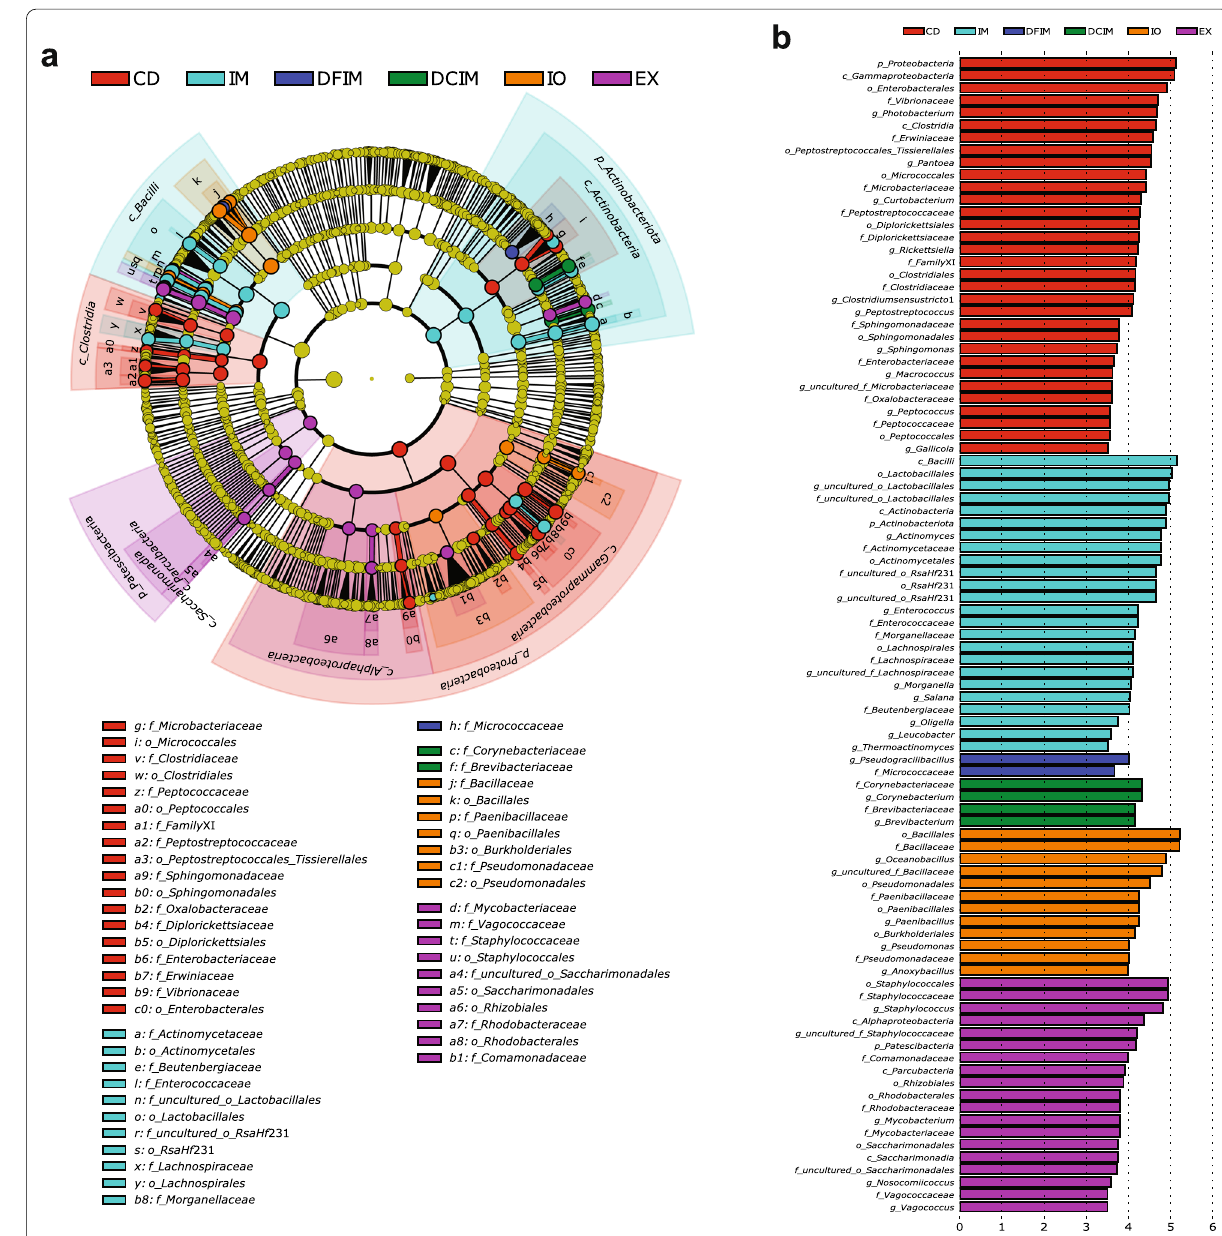
Fig. 3 Linear discriminant analysis (LDA) effect size (LEfSe) results on gut microbiota of fish. Circular cladogram reporting LEfSe results presents the identified amplicon sequence variants (ASVs) distributed according to phylogenetic characteristics around the circle ( a ). The dots closest to the center represent ASVs at the phylum level, whereas the outer circle of dots represent ASVs at the genus level. The color of the dots and sectors indicate the dietary group in which the respective ASVs are most abundant. The color explanation is given above the cladogram. Yellow color indicates ASVs that showed similar abundance in all dietary groups. The colored sectors give information on phylum, class (full name in outermost circles, given only for phylum or class showing significant difference between groups), order, family, and genus (indicated by letter). The explanation is given below the cladogram. Indicator taxa with LDA scores of 3.5 or greater in the microbial communities ( b ). p phylum; c class; o order; f family; g genus; CD control diet; IM full-fat BSF (black soldier fly) larvae meal diet; DFIM defatted BSF larvae meal diet; DCIM de-chitinized BSF larvae meal diet; IO BSF larvae oil diet; EX BSF larvae exoskeleton